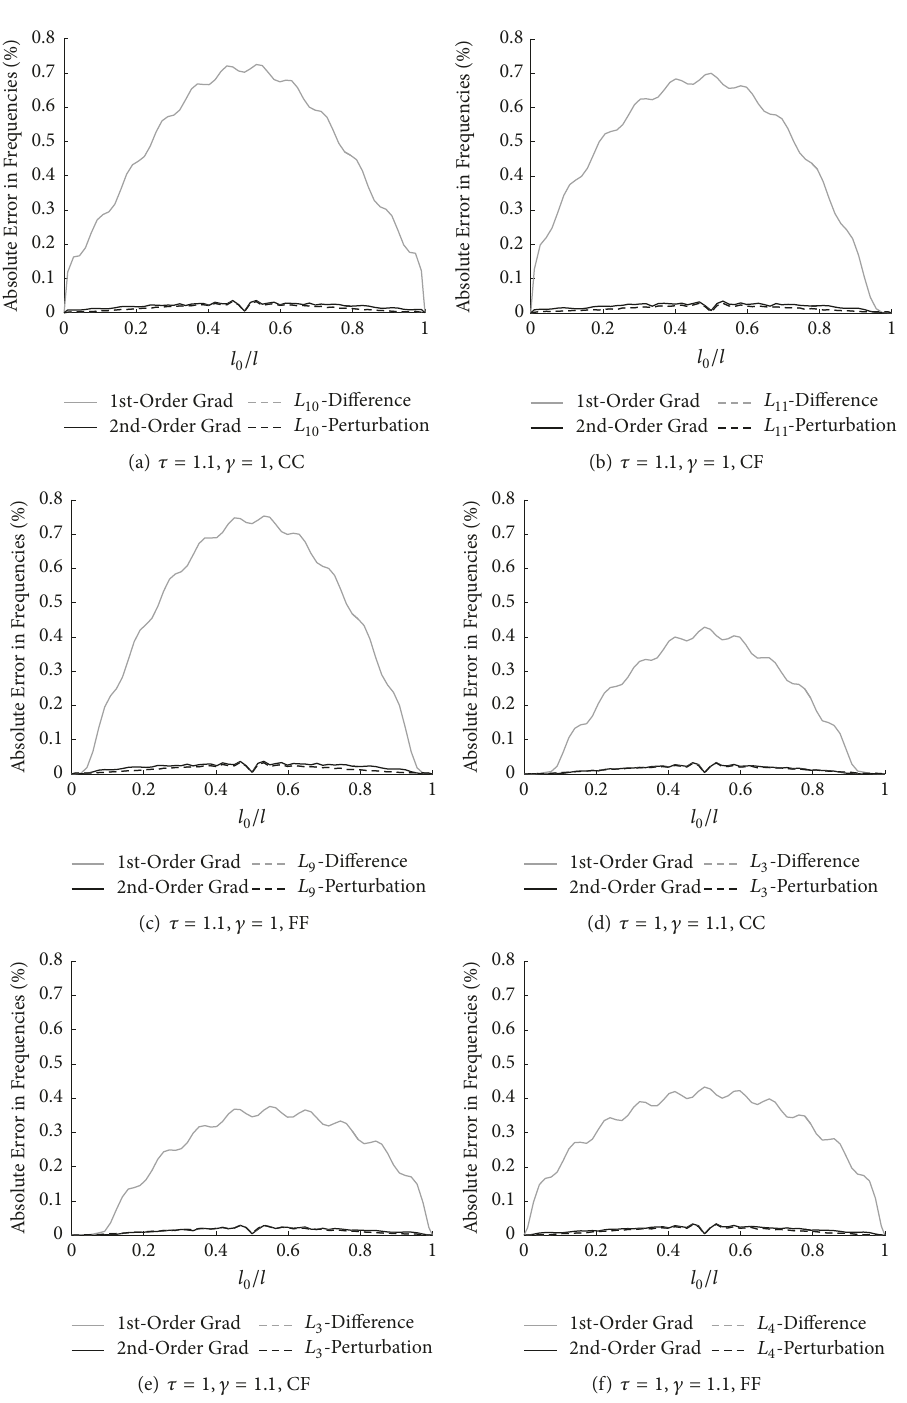
Figure 6: Frequency error results with an increase in 𝛾 or 𝜏 for variable 𝑙 0 /𝑙 .